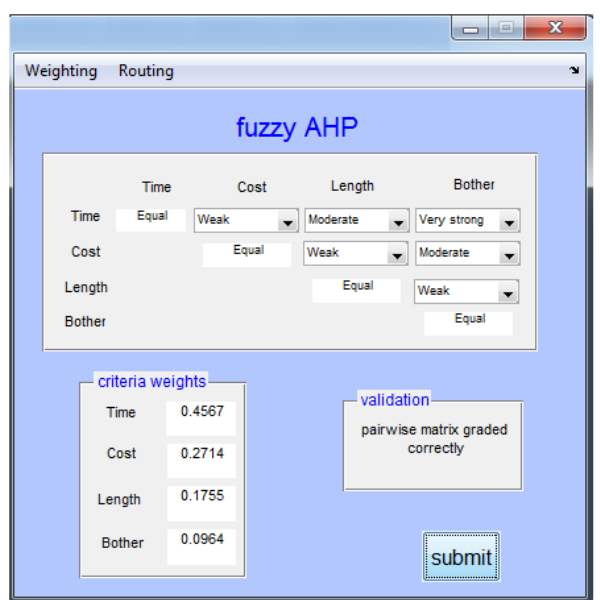
Figure 6. The devoted configuration wizard for the pairwise compression Figure 9. The best fitness value of the achieved routes over 100 independent runs under different neighbour numbers.